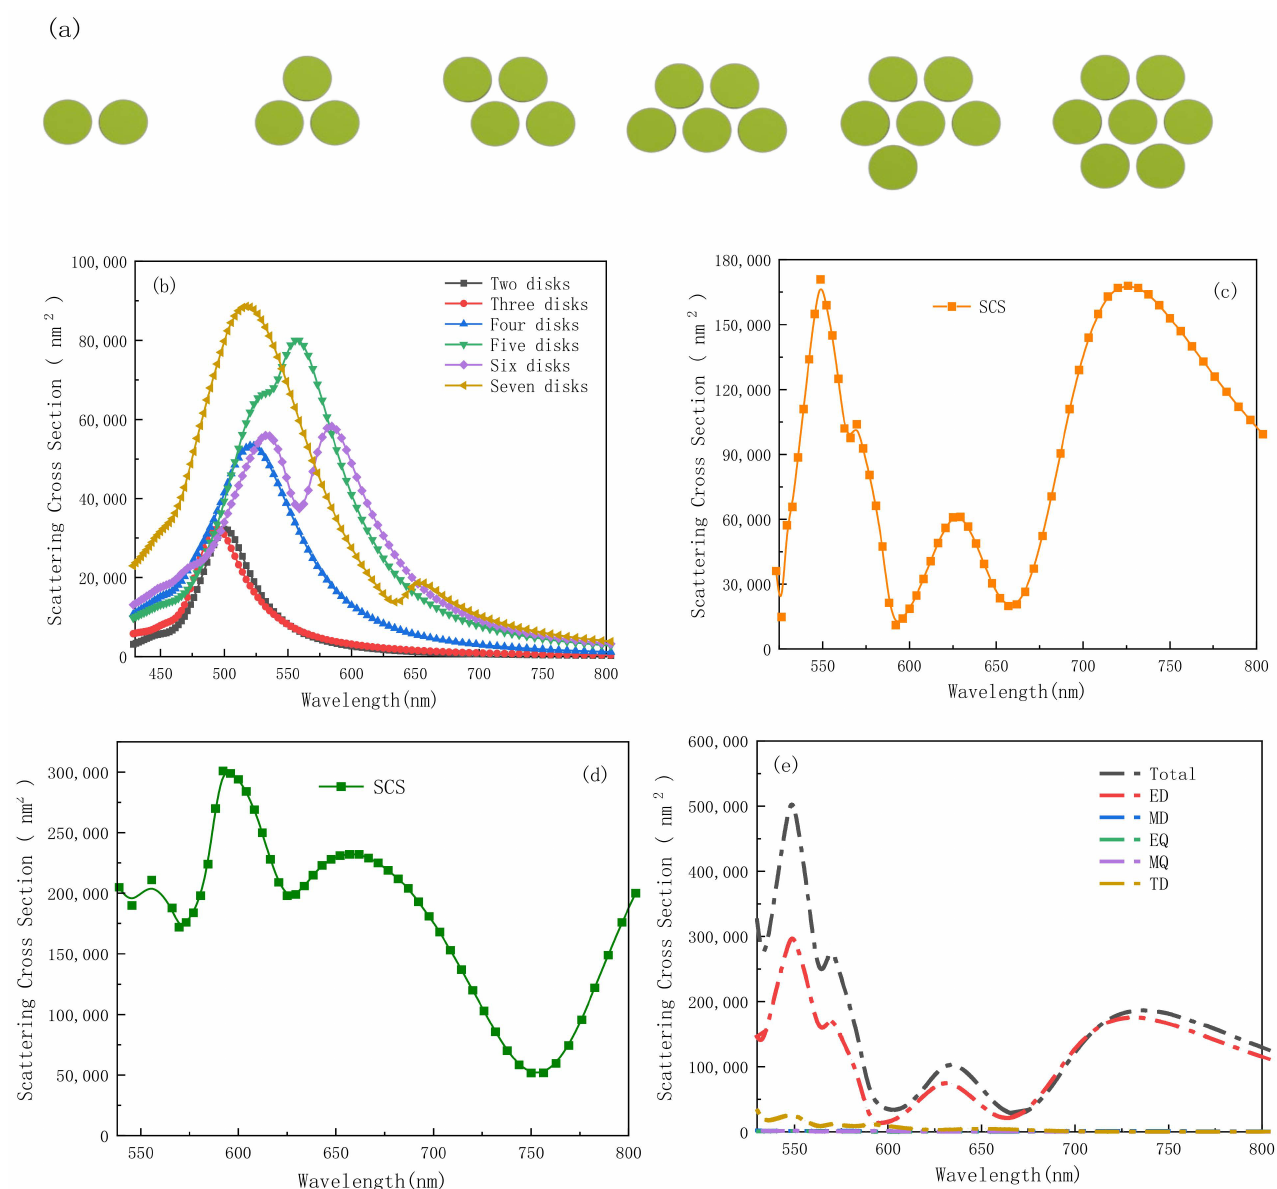
Figure 2. ( a ) Arrangement of the silver disks; ( b ) comparison of the scattering cross-sections for different arrangements of the nanodisks; ( c ) scattering cross-section of the hybrid nanostructures; ( d ) scattering cross-section of the hybrid nnoantennas after adding the substrate for silicon materials; ( e ) multipole contributions to the scattering